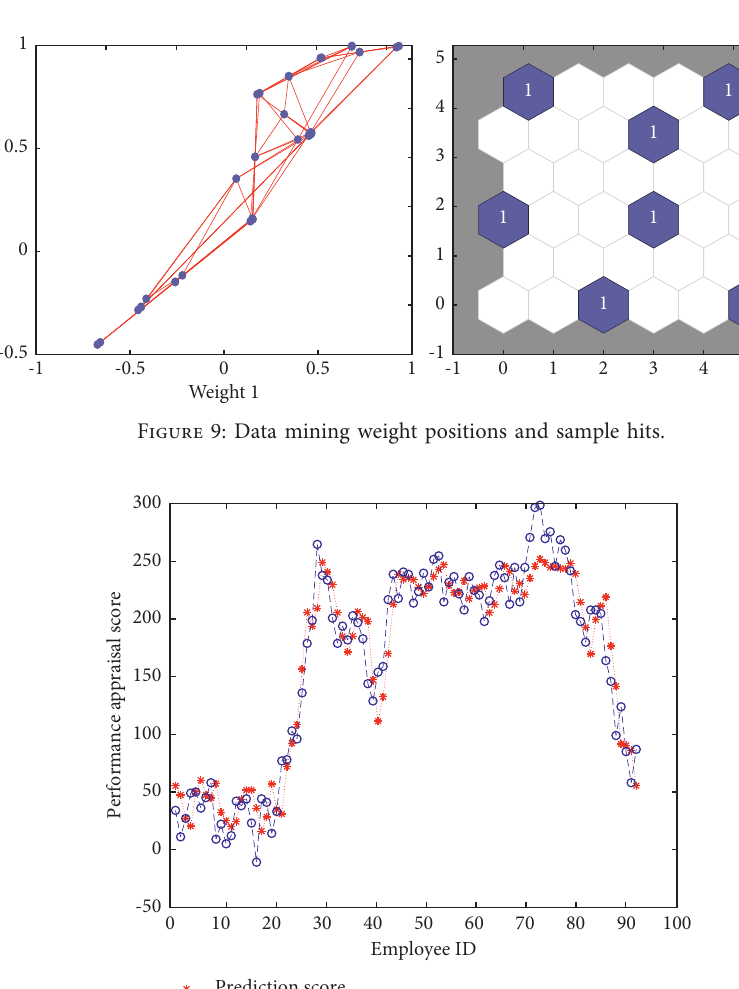
Figure 8: Input planes.